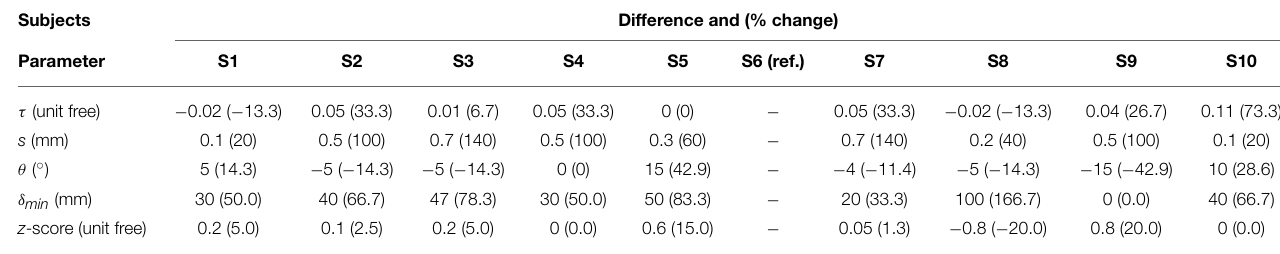
TABLE 5 | Difference between reconstruction parameters across subjects, using S6 as reference.